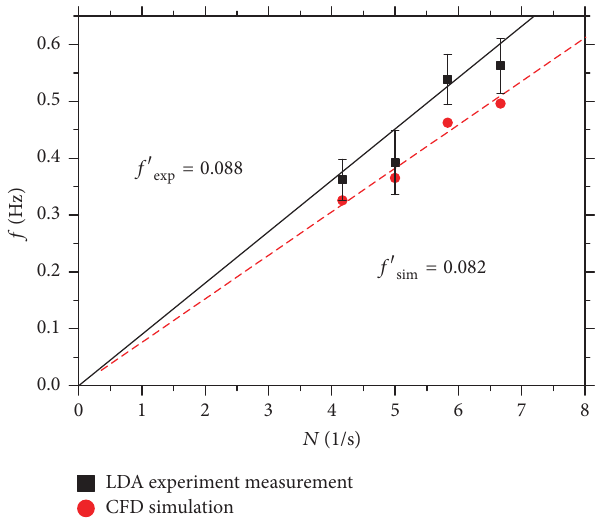
Figure 7: MI frequency as a function of impeller rotational speed at point. 𝐻 𝑇 /𝐷 𝑇 = 0.5 , r/ 𝐷 𝑇 = 0.30 , z/ 𝐷 𝑇 = 0.25, and 𝜃 = 0 ∘ . is carried out among transient, steady cases and multiblock model [19], so that the influence of the MI on SMD in PBM- CFD simulations is investigated. The contour of the SMD on plane ( 𝑟/𝐷 𝑟 = − 0.5 ∼ 0.5, z/ 𝐷 𝑟 = − 0.5 ∼ 0.5, 𝜃 = 45 ∘ ) in transient and steady cases